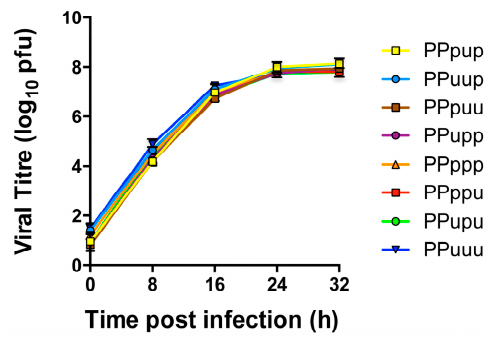
Figure 6. Growth kinetics of reverse genetics-derived PR8(Ud-NA, 5 (cid:48) chimeric PB1) viruses. Madin-Darby canine kidney (MDCK) cells were infected with viruses containing 5 (cid:48) chimeric PB1 genes at an MOI of 0.01. At the indicated time points, the amount of infectious virus released into the supernatant was determined by plaque assay. The data represent the mean and range of two individual experiments.